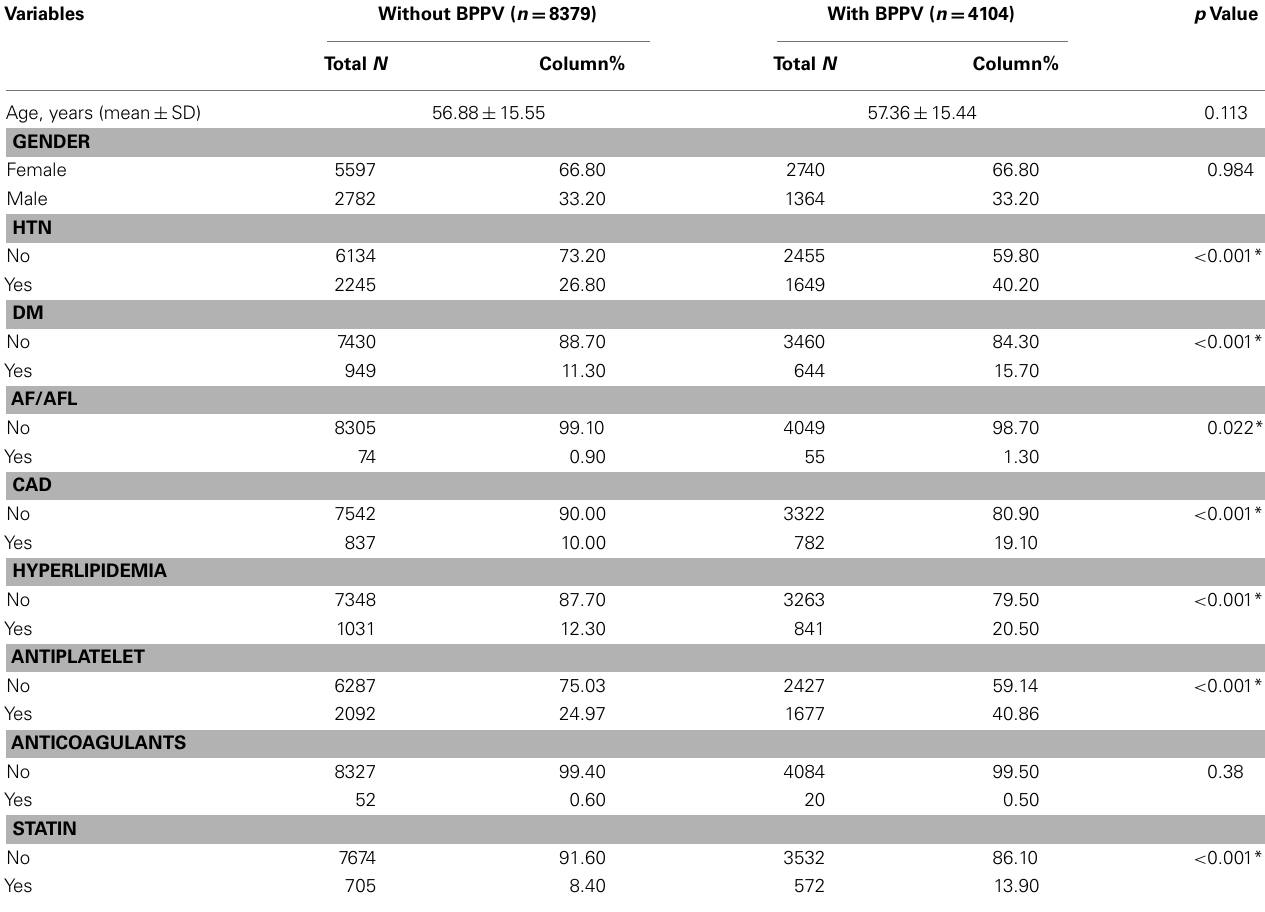
Table 1 | Demographic and clinical characteristics comparisons between subjects with and without BPPV ( n = 12483) .